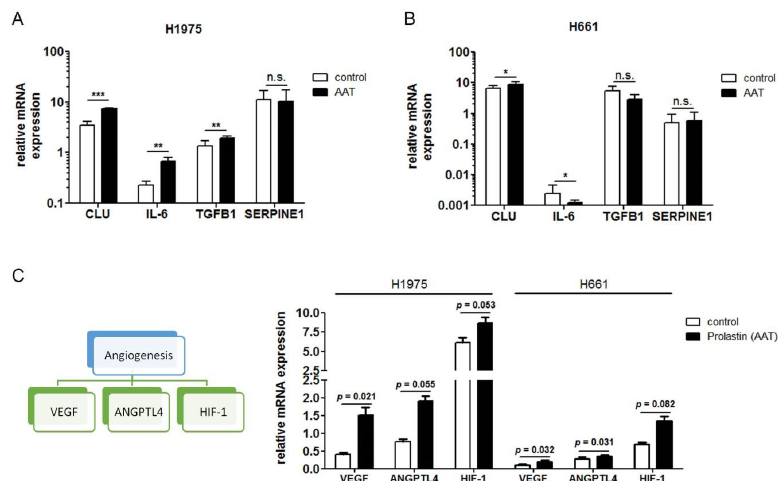
Figure 7. Validation of AAT-regulated genes in H1975 and H661 by qPCR. ( A) and ( B) Gene expression relative to housekeeping gene POLR2A of selected genes from RNA-seq analysis of H1975 and H661. Data presented as the mean ± SD from three independent measurements. ( C) Gene expression relative to housekeeping gene POLR2A of genes involved in angiogenesis and hypoxia. * p < 0.05, ** p < 0.005, *** p < 0.001.